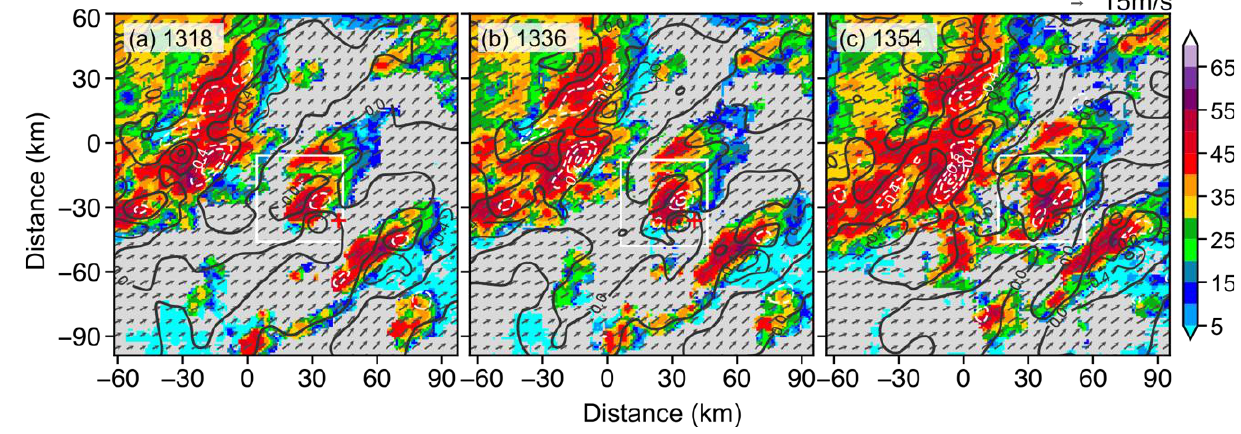
Figure 9. Evolution of the vertical vorticity (contours), horizontal winds (vector), and reflectivity (shaded) on 3 km height at 1318 ( a ), 1336 ( b ) and 1354 ( c ) LTC. The white (black) contours are negative (positive) vorticity, and the bold black contours indicate the value of 0. The red cross represents the tornado location. The white box is the VWP analysis area.